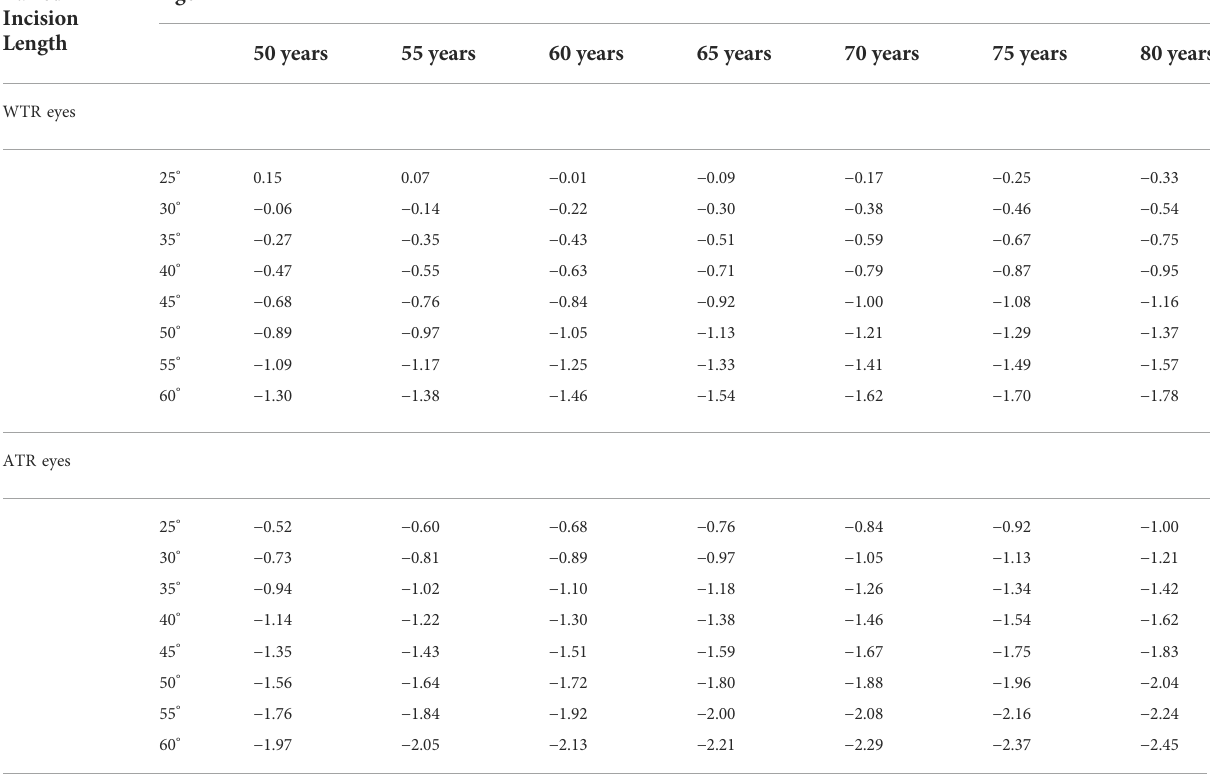
TABLE 4 Nomogram: total net corneal change (WTW-ATW changes) based on age and length of FSAKs in paired group with WTR and ATR corneal astigmatism. Paired Incision Length